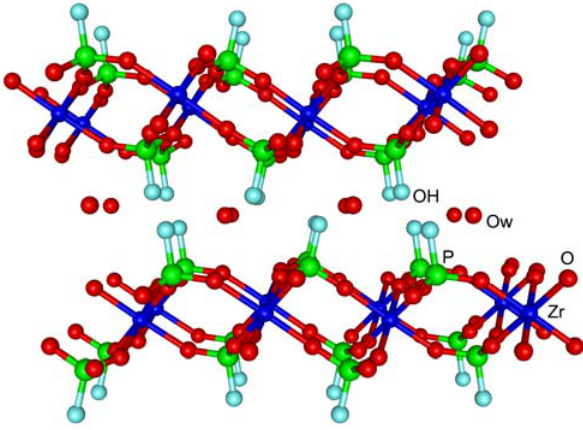
Figure 1. Chemical structure of α‐ ZrP.